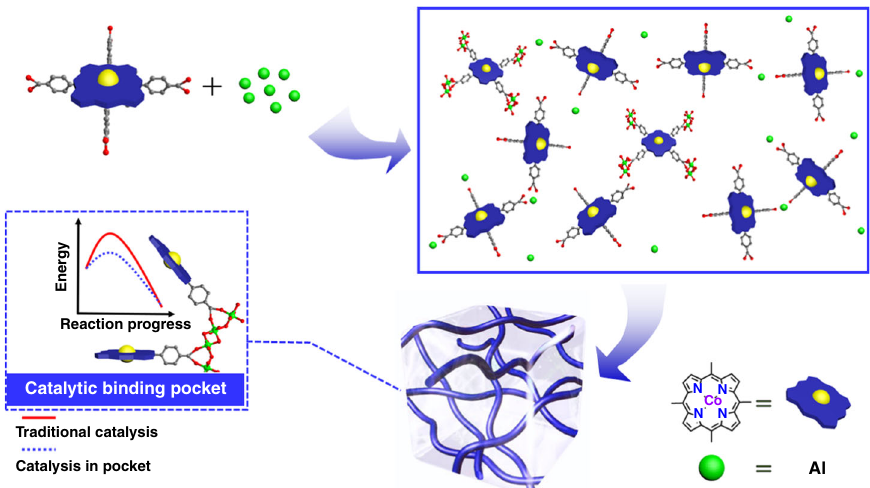
Fig. 1 Schematic representation of the formation of Co-MMPG and its activation energy diagram with traditional catalysis and synergistic catalysis. MOGs engender a catalytic binding pocket that decreases the activation energy, and, in turn, enhance catalytic performance including both conversion and chemo/stereo